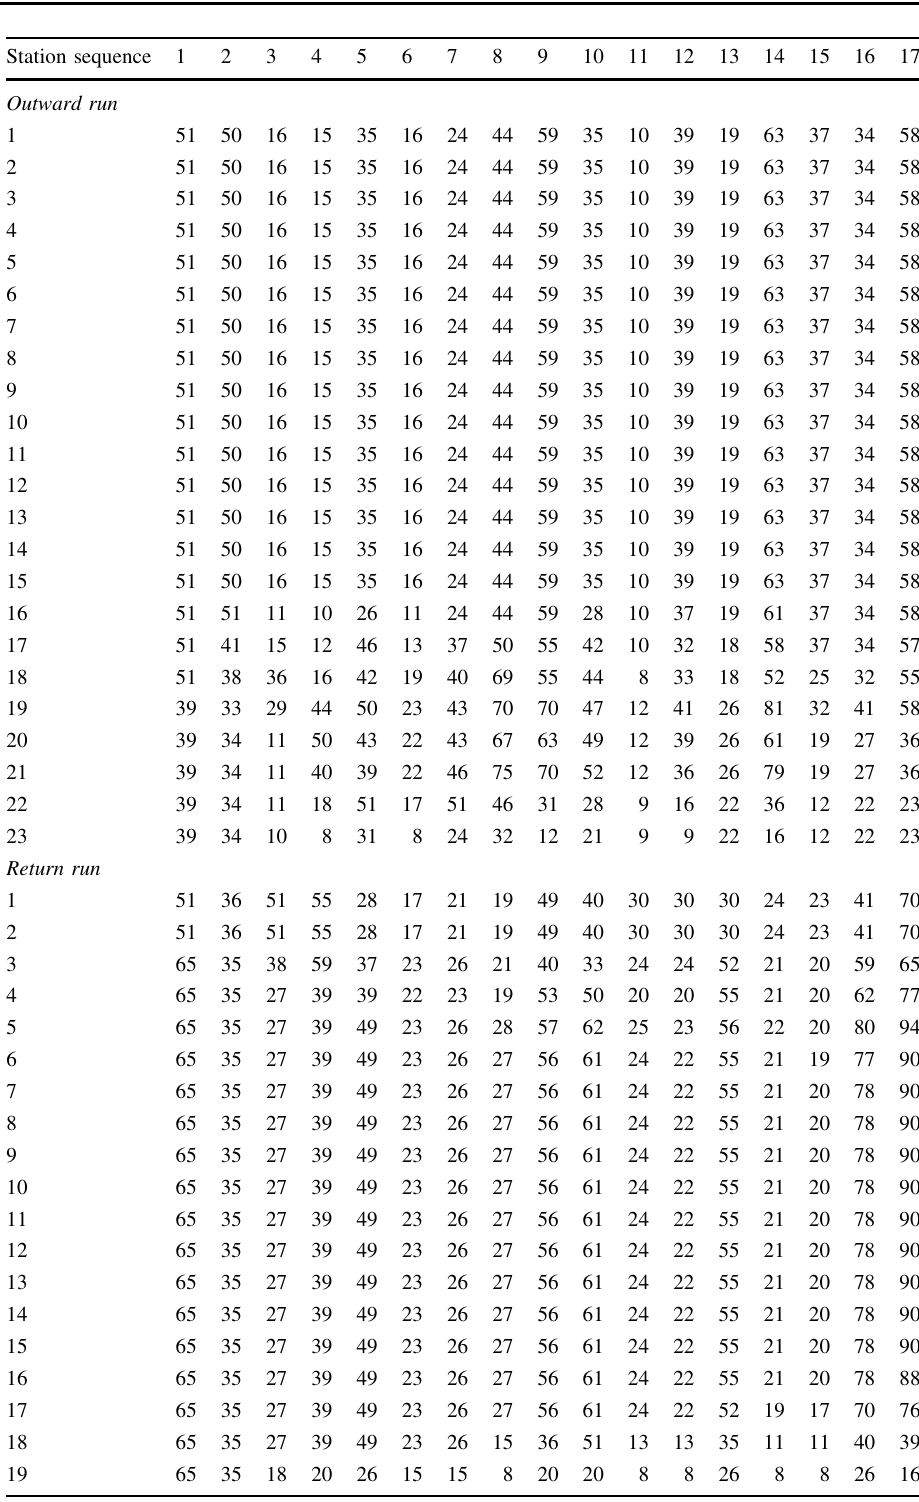
Station sequence